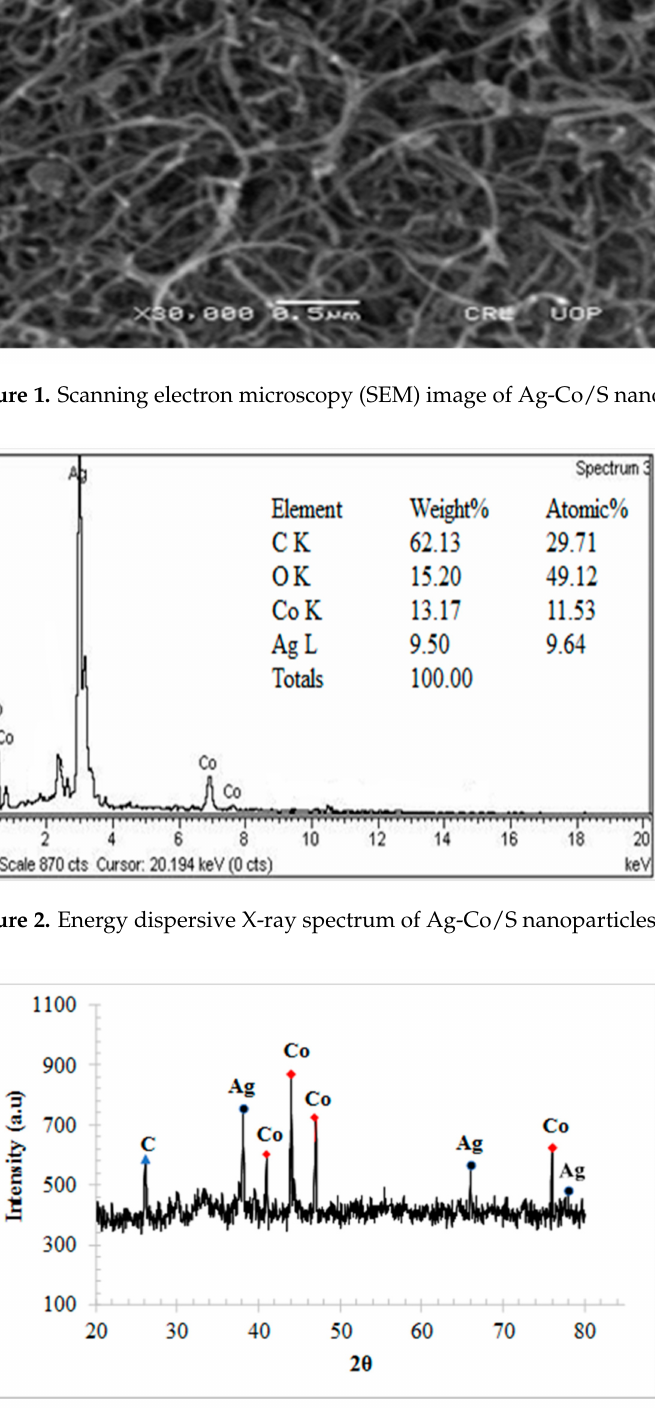
Figure 3. X-ray diffractometry image of Ag-Co/S